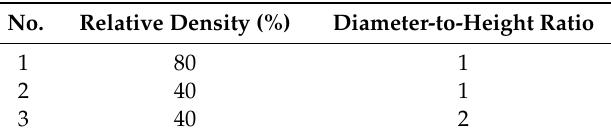
Table 1. Specimen conditions tested in this study.